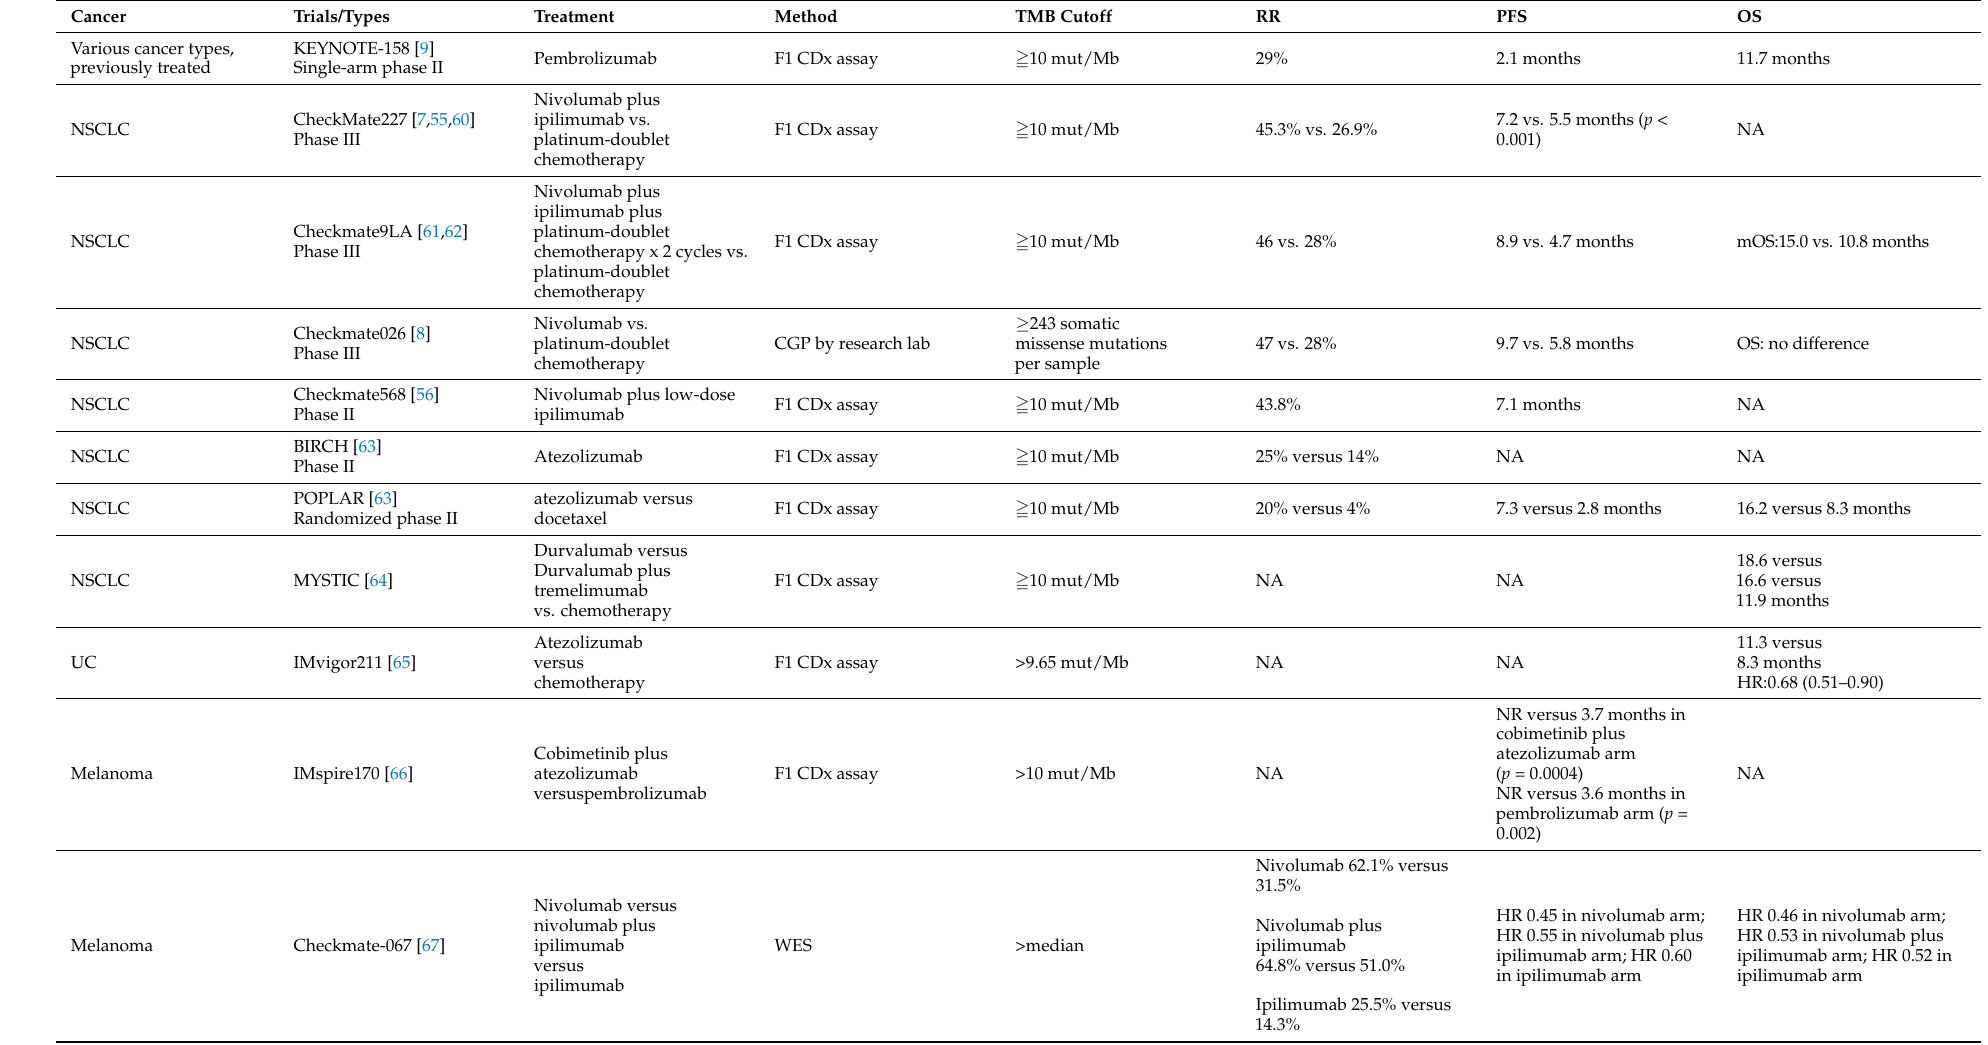
Table 4. Results of important clinical trials that explored high tissue TMB as potential